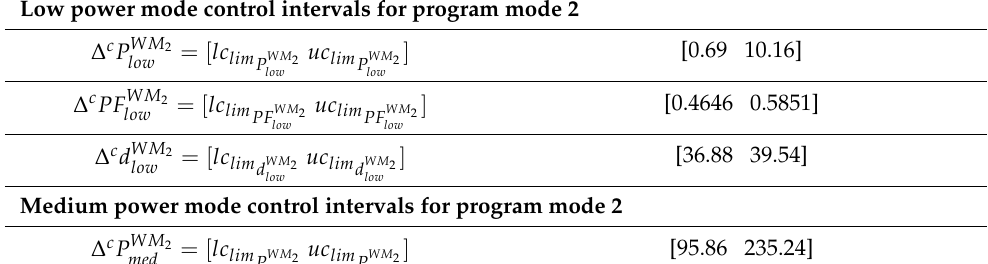
Table 2. Control intervals of CC-AD method for program mode 2 of WM Low power mode control intervals for program mode 2